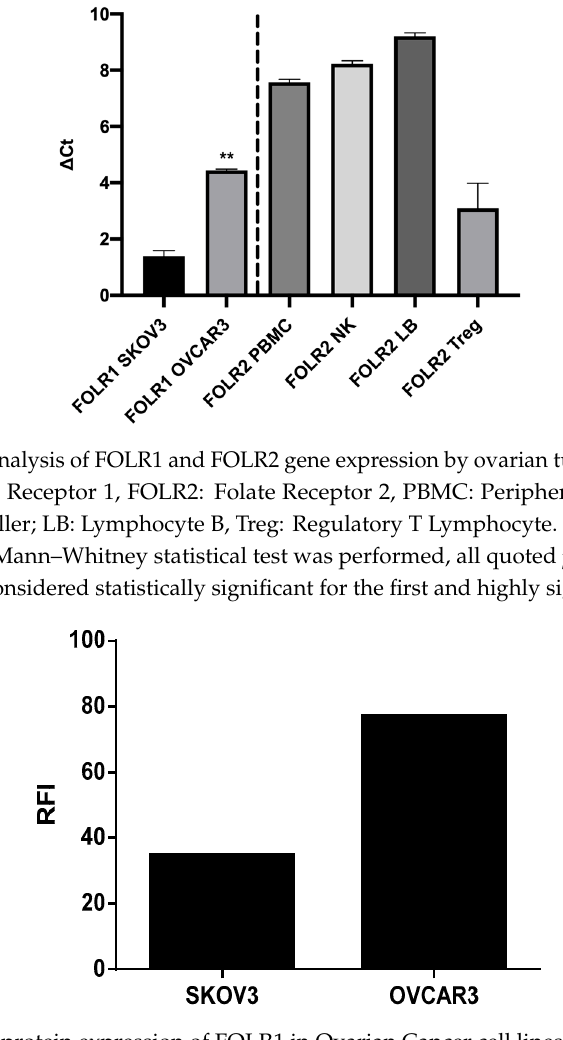
Figure 2. Membrane protein expression of FOLR1 in Ovarian Cancer cell lines using Flow Cytometry and analyzing by the FlowJo Software. Fluorescence intensity representation (RFI).